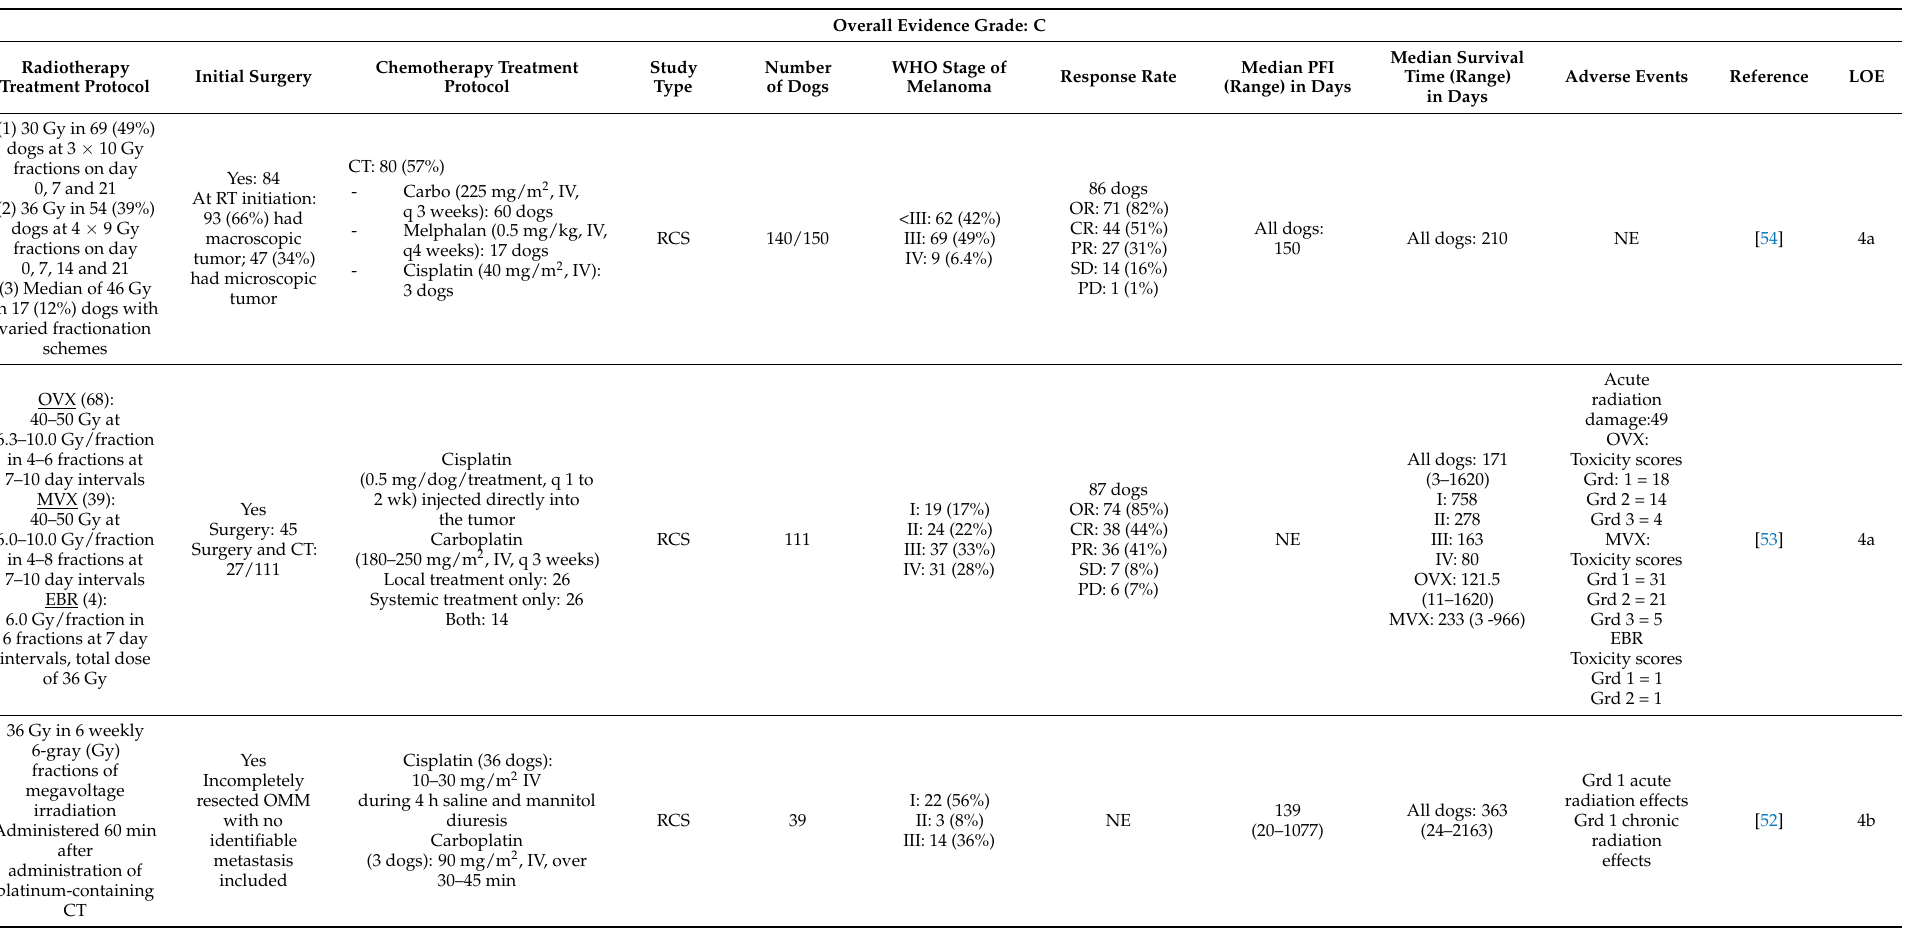
Table 4. Summary of radiotherapy with adjunctive therapy studies evaluating effectivity in oral malignant